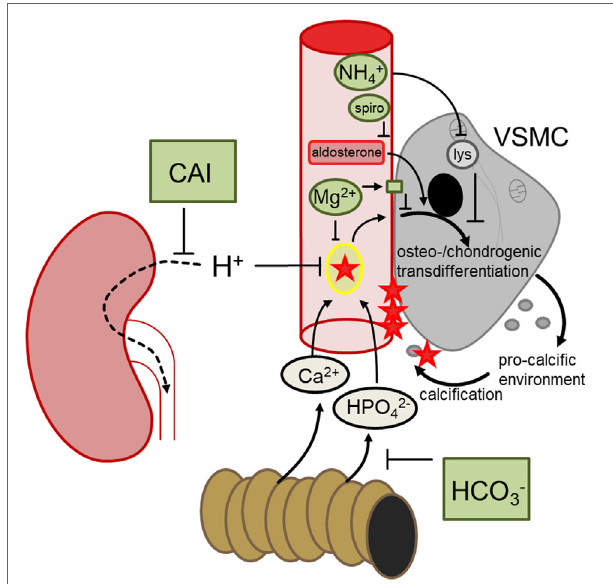
FigURe 2 | Hypothetical mechanisms involved in the discussed treatments preventing vascular calcification. During hyperphosphatemia, phosphate complexes with calcium and forms secondary calciprotein particles, inducing osteo-/chondrogenic transdifferentiation of vascular smooth muscle cells (VSMCs), which in turn generates a pro-calcific environment and subsequent active tissue mineralization. Oral bicarbonate treatment may impair intestinal phosphate reabsorption, ameliorating hyperhosphatemia. Renal carboanhydrase inhibition causes proton retention, which may reduce the formation of calcium-phosphate nanoparticles. Magnesium may similarly directly prevent calcium-phosphate complexation and stimulates the calcium sensing receptor in VSMCs, blunting osteo-chondrogenic transdifferentiation. This transdifferentiation is also directly stimulated by aldosterone, which may be blunted by spironolactone (spiro). Ammoniumchloride leads to lysosomal (lys) alkalinization which appears to dissipate the osteo-chondrogenic transdifferentiation of VSMCs. These mechanisms may provide the basis to develop a therapeutic approach to reduce the burden of vascular